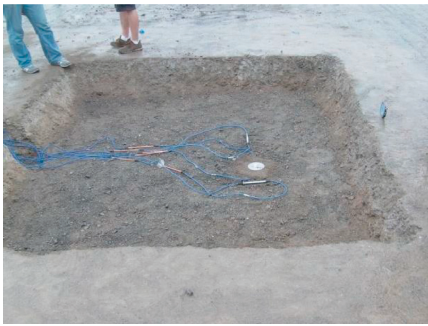
Figure 4: The instrument and